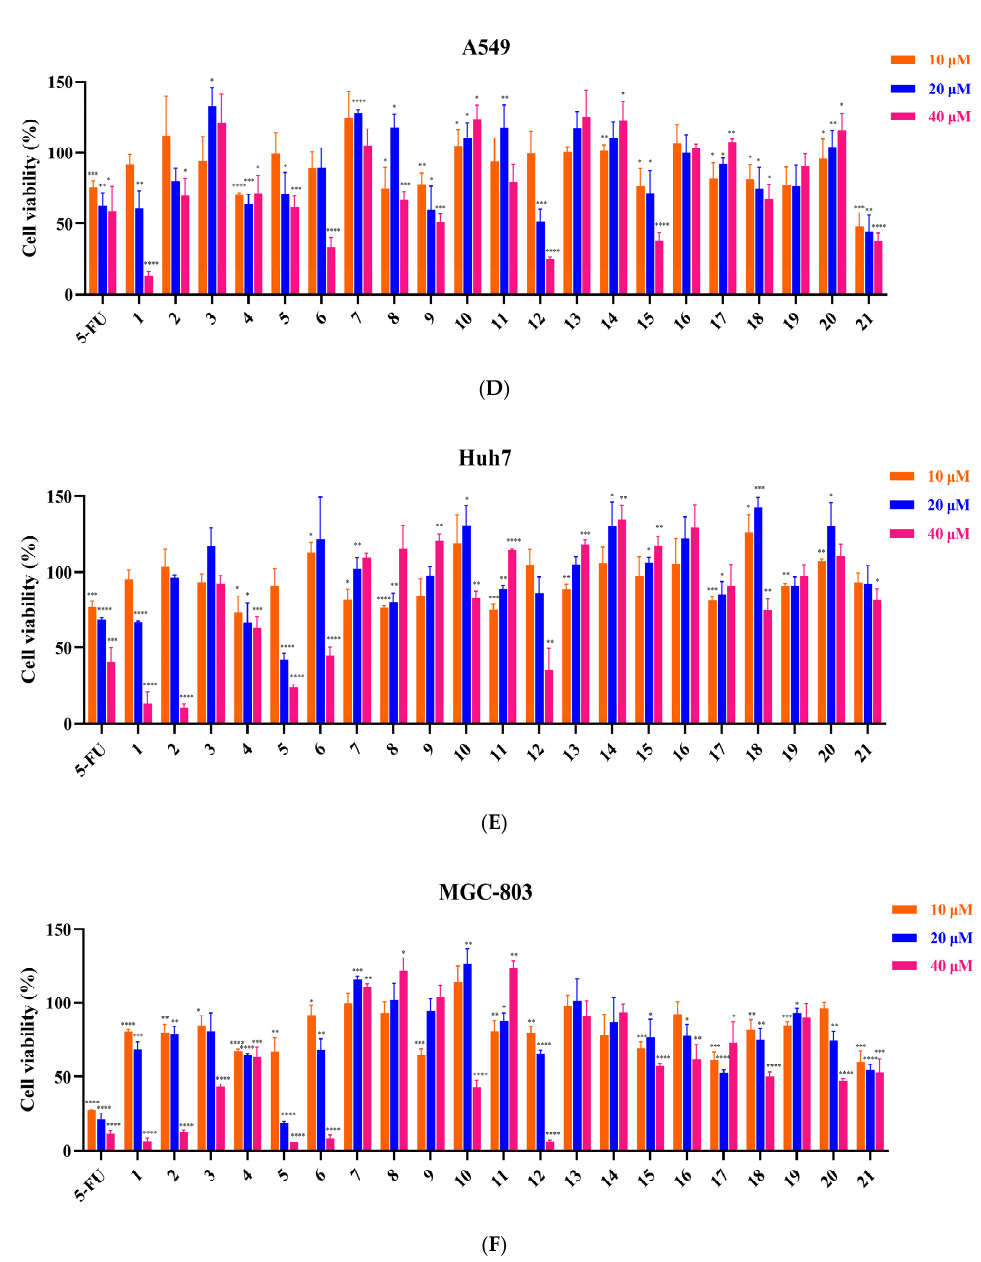
Figure 3. The effect of 21 compounds on 6 tumor cell lines ( A – F ) treated with 10, 20 and 40 μ M for 48 h. Percent cell viability was expressed as mean ± SD. * p < 0.05, ** p < 0.01, *** p < 0.001, **** p < 0.0001, in comparison to control groups. Table 2. IC 50 values ( μ M) of several compounds with better inhibitory effects.